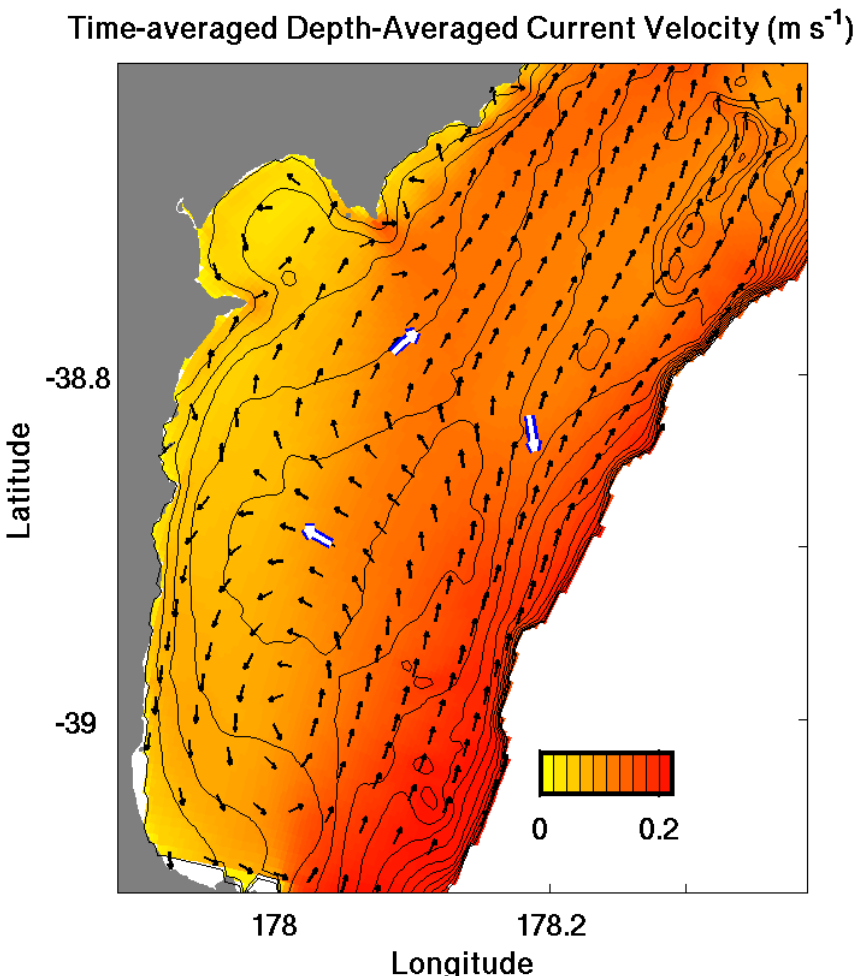
Figure 8. Map of estimated time-averaged depth-averaged current speed (shading; m s −1 ) and direction (black arrows). Long white arrows with blue outlines indicate observed current direction for tripod deployments. Black bathymetric contours indicate every 10